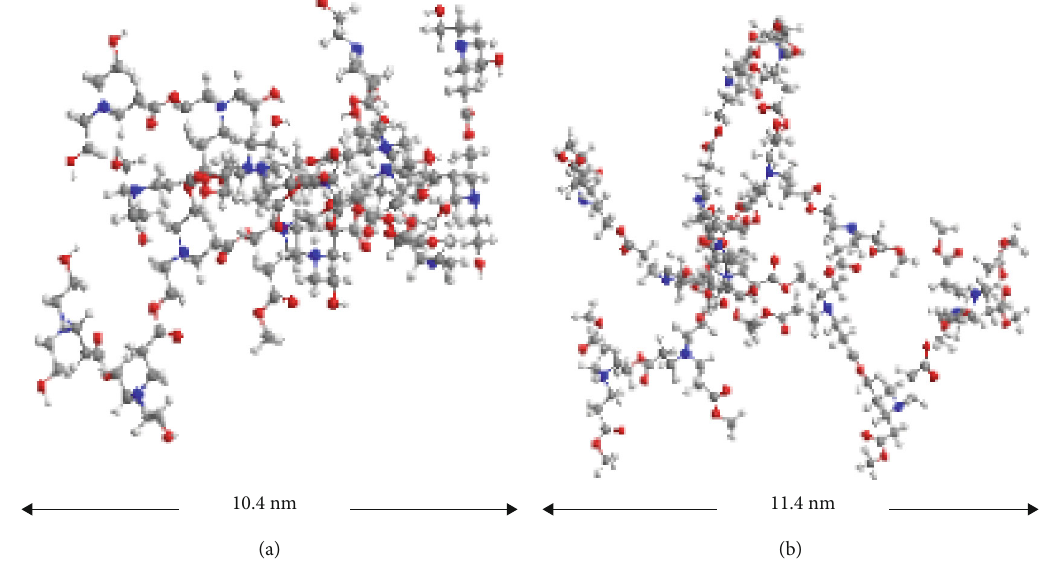
Figure 2: Expected molecular diameter of (a) HBP1-3.0 K and (b)